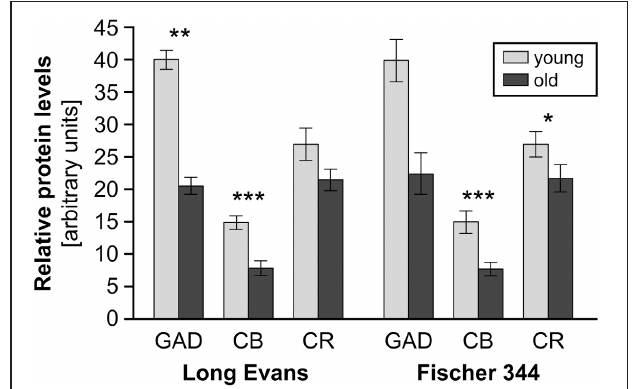
FIGURE 4 | The results of western blot protein analysis of GAD67, calbindin (CB) and calretinin (CR) in the IC of young and old Long-Evans and Fischer 344 rats. Arbitrary units were calculated as the ratio between the optical density of the examined protein and the optical density of actin (in scanned films analysed using ImageQuant software). The heights of the columns for GAD67, CB, and CR cannot be mutually compared; they are dependent on the ratio of protein levels between the IC and the cortical areas for each examined protein. The tall column for GAD67 (in arbitrary units) indicates a larger amount of GAD67 per unit tissue weight in the IC when compared to the cortex (and conversely for CB). Due to the limited number of old Fischer 344 rats available for GAD67 protein analysis, the data did not demonstrate statistically significant differences in this case. The graph is constructed from data presented in Burianova et al. (2009); Ouda et al. (2012b). The error bars represent S.E.M. ( ∗ P < 0 . 05, ∗∗ P < 0 . 01, ∗∗∗ P < 0 .